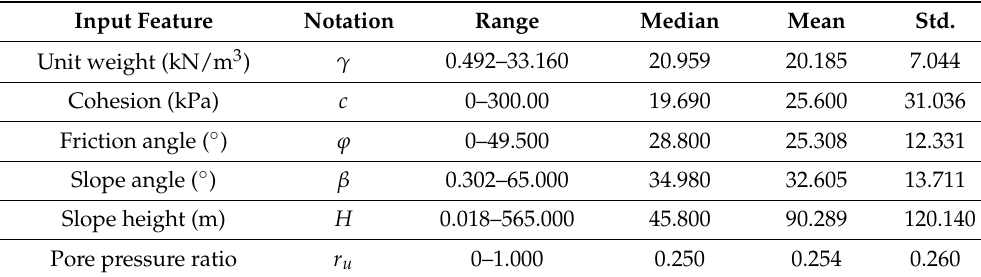
Figure 1. Ridgeline plots showing the density distributions of the input features. The inset shows a schematic diagram of the circular failure model. Table 2. Summary of the input feature